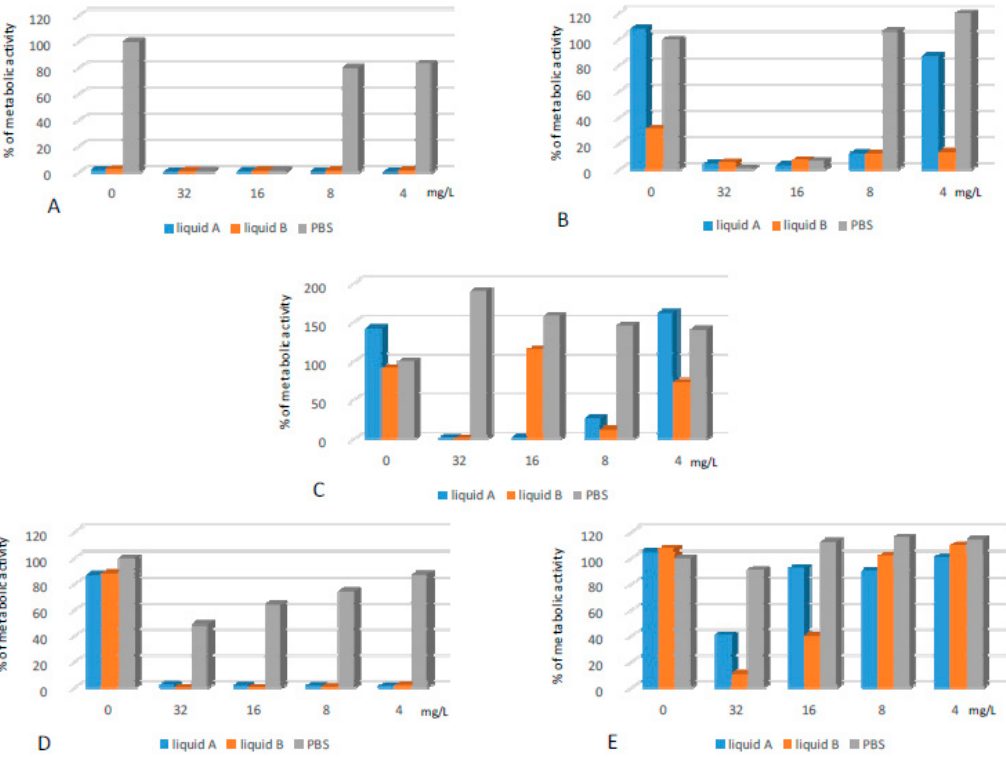
Figure 8. Activity of CL liquids alone and supplemented with the lipopeptide applied at concentrations of 4–32 mg/L against biofilms formed on CL by: ( A ) SE; ( B ) SA; ( C ) EF; ( D ) EC; and ( E ) PA. The results are presented as the percentage of metabolic activity in comparison to positive (100%) and negative (0%) controls; RSD ≤ 20%.